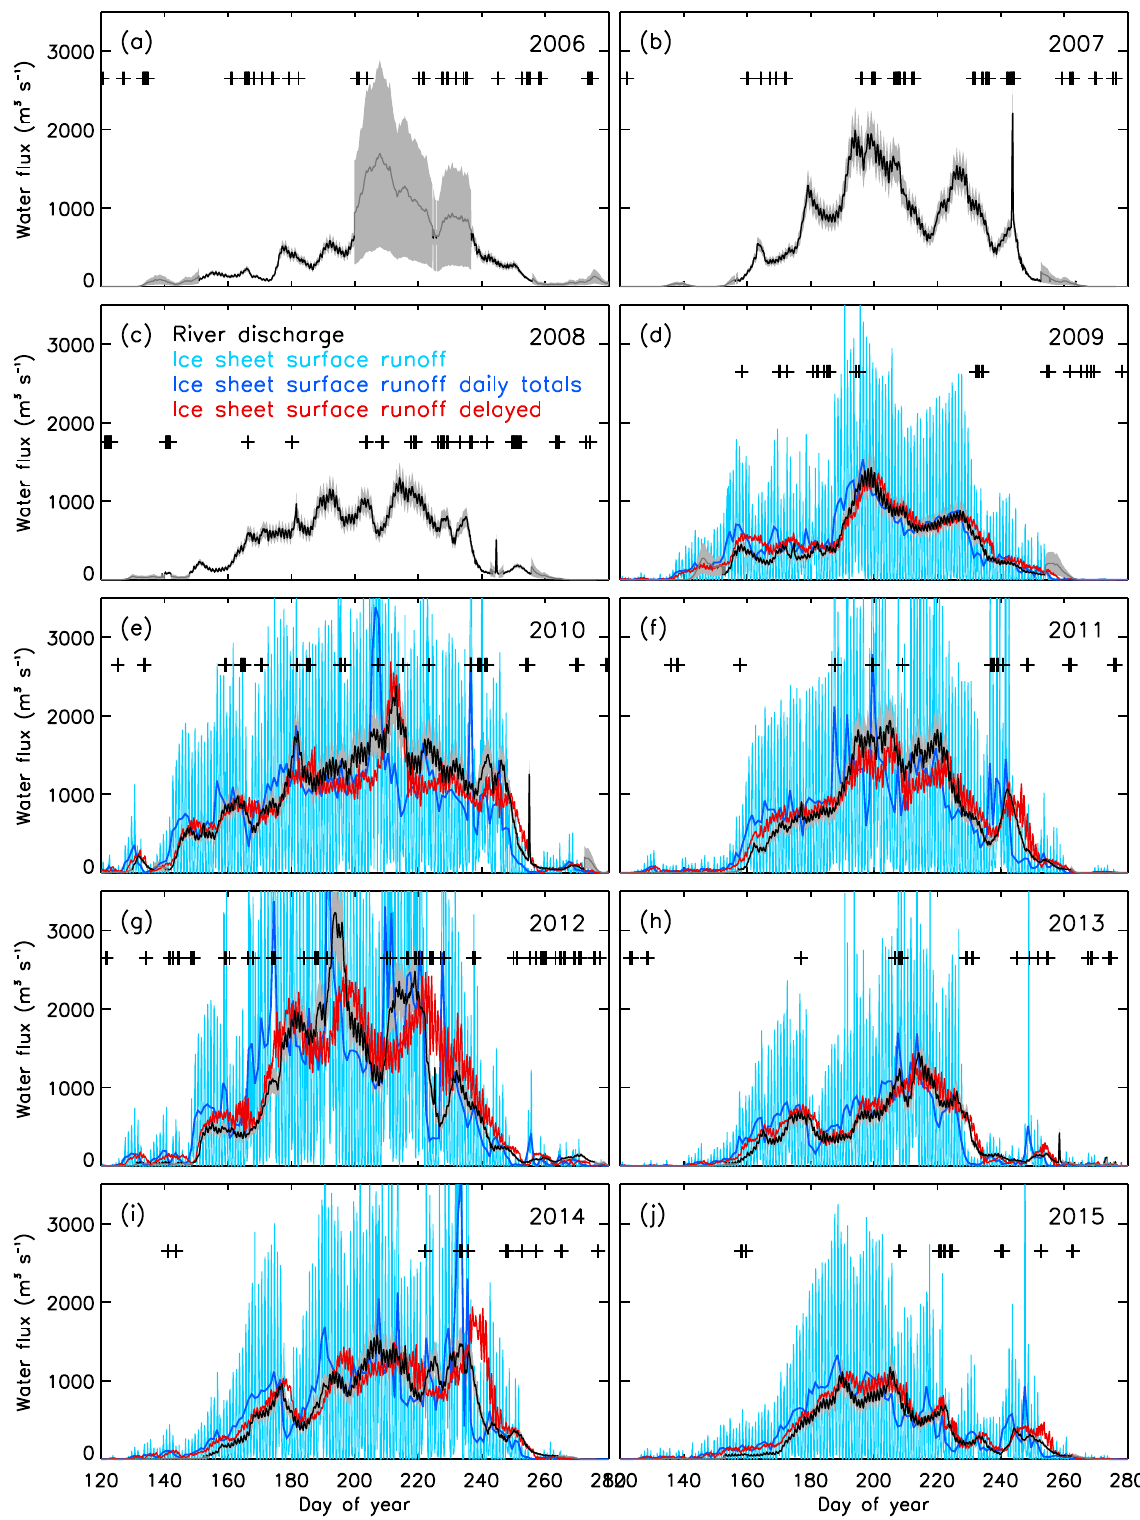
Figure 7. Hourly Watson River discharge (black), and hourly (light blue) and daily (dark blue) catchment-total ice sheet surface meltwater runoff. The red line gives meltwater runoff with elevation-dependent routing delay. Dark grey lines are river discharge estimated from temperature (see Methods section). Light grey areas represent discharge uncertainty. Plus symbols give the timing of precipitation events in Kangerlussuaq exceeding 1mm in